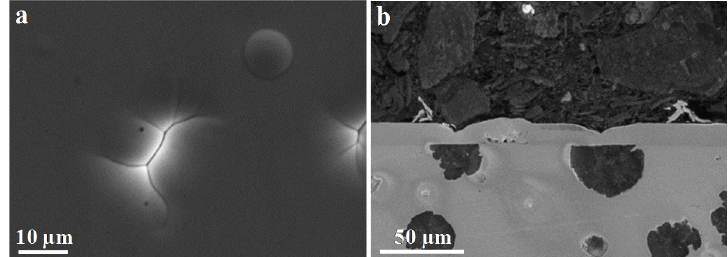
Figure 7. Ni ‐ P coating obtained on the SG cast iron after 60 min at T = 84 °C. ( a ) SEM top ‐ view observation (SE detector); and ( b ) SEM cross ‐ sectional ‐ view observation (SE detector).